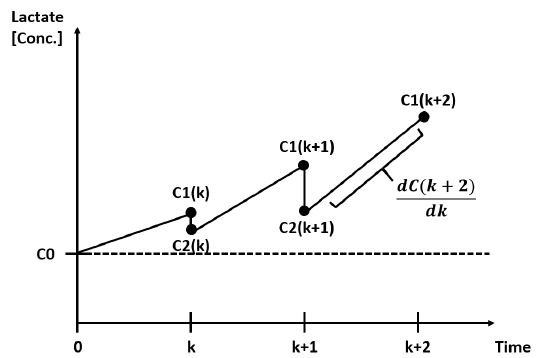
Figure 2. Simplified lactate concentration graph during a cell expansion period with medium replacements at time points 𝑘, 𝑘 + 1 and 𝑘 + 2 .